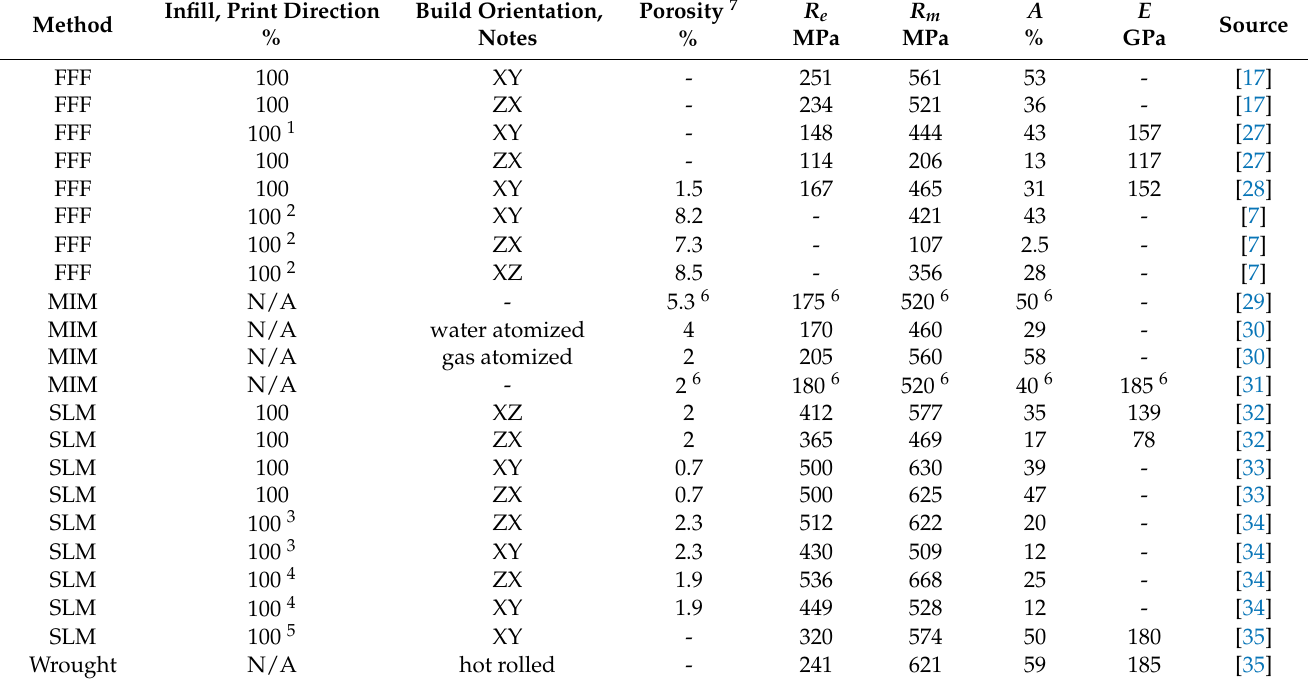
Table 10. Overview of tensile properties for 316L stainless steel produced using metal FFF, SLM and